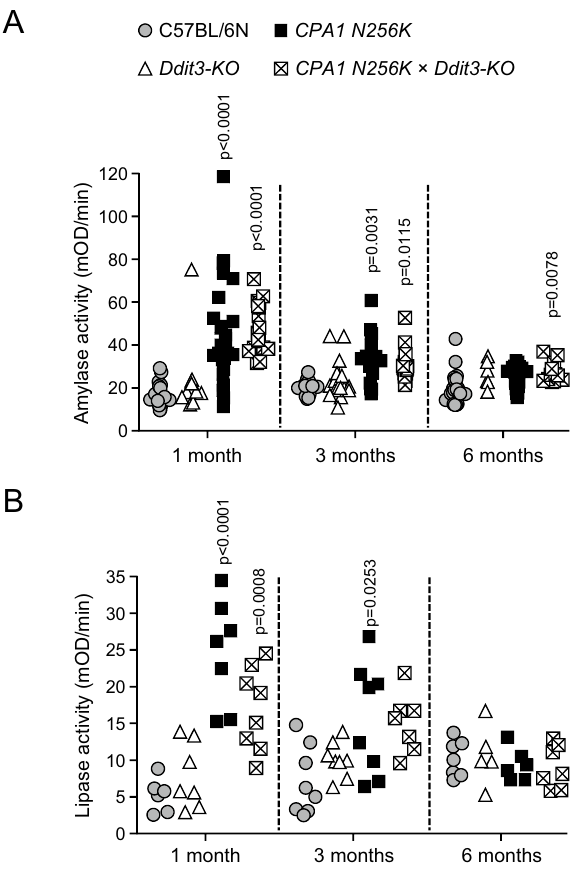
Figure 4. Plasma amylase and lipase activity in CPA1 N256K × Ddit3-KO mice. ( A ) Plasma amylase activity of mice at 1, 3, and 6 months of age. C57BL/6N (n = 23, 15, and 25), Ddit3-KO (n = 10, 17, and 6), CPA1 N256K (n = 24, 15, and 11), CPA1 N256K × Ddit3-KO (n = 18, 16, and 12). ( B ) Plasma lipase activity of mice at 1, 3, and 6 months of age. C57BL/6N (n = 6, 8, and 7), Ddit3-KO (n = 7, 8, and 5), CPA1 N256K (n = 7, 8, and 6), CPA1 N256K × Ddit3-KO (n = 8, 7, and 7). Individual data points are